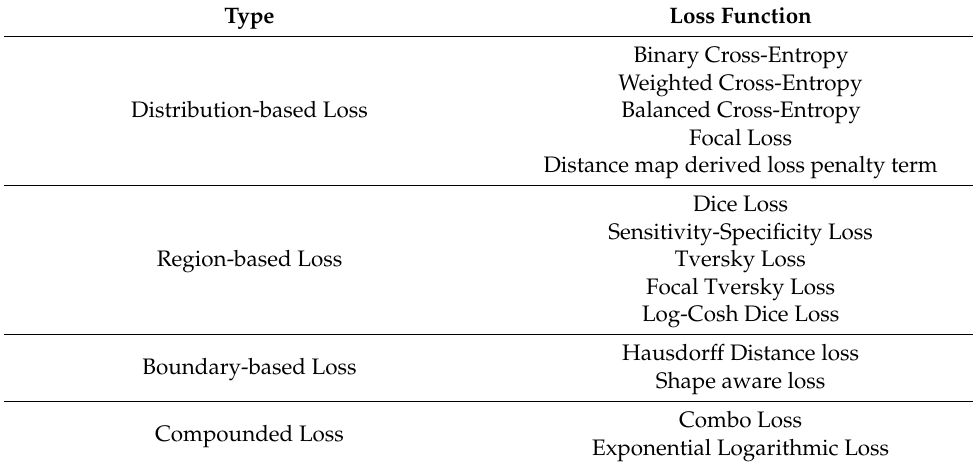
Table 4. Distribution of loss functions based on its